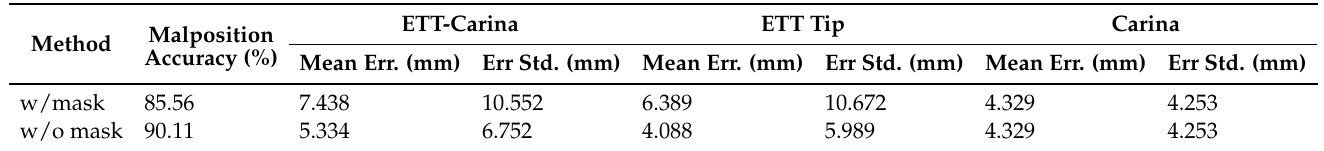
Figure 8. Refining the feature point of ETT tip/Cairna by the bbox of ETT/Bifurcation. ( a ) Without post-process. ( b ) With post-process. Table 22. The results of adopting mask prediction or not in the post-process